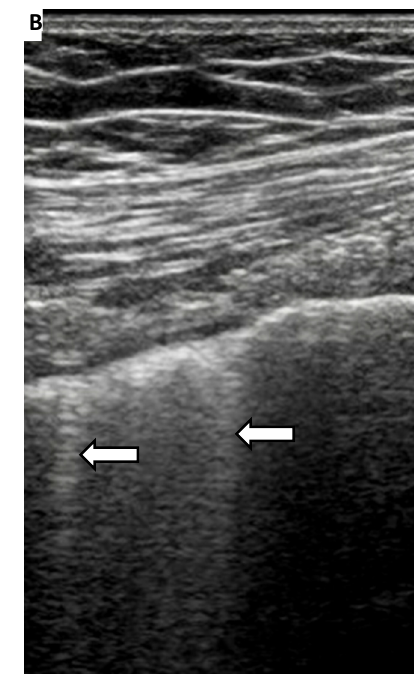
Figure 2. To the left ( A ), an HRCT scan of a patient with systemic sclerosis showing extensive ground-glass opacities and reticulations with traction bronchiectasis (white arrows) in the basal regions of both lungs. The findings are compatible with a fibrotic NSIP pattern. Note also, in this case, a dilated esophagus (black arrow). To the right ( B ), ultrasonographic scans (4–13 MHz broadband linear transducer) with the presence of 2 ultrasound B-line (white arrows) in the same patients. Less frequently, a usual interstitial pneumonia (UIP) pattern, characterised by honey- combing and traction bronchiectasis, may also be present (Figure